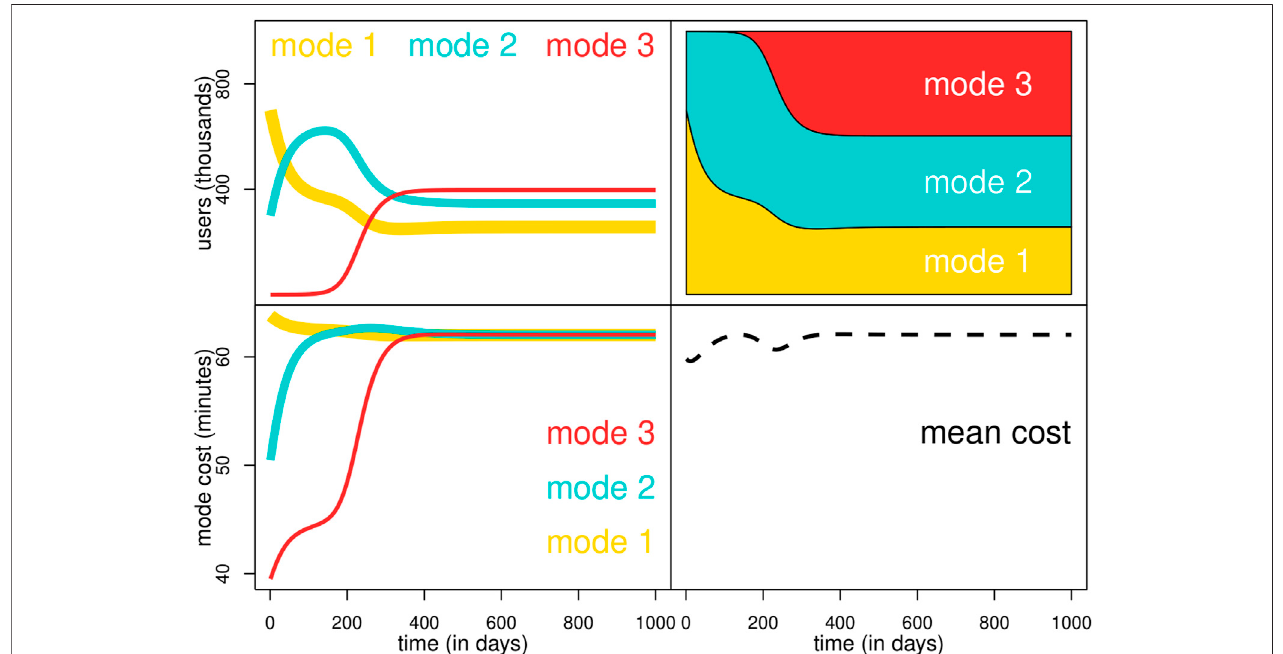
FIGURE 1 | Modal share (vertical axis) versus time measured in some dimensionless scale, marked as “ days, ” so it is a slow process compared to the commutes (horizontal axis) for N = 1, 000, 000 individuals, and some initial distribution, considering three transport modes. The top panels indicates the number of users and their frequency. The bottom panels is the commuting time in minutes for each transport mode and the mean commuting time experienced by all users.